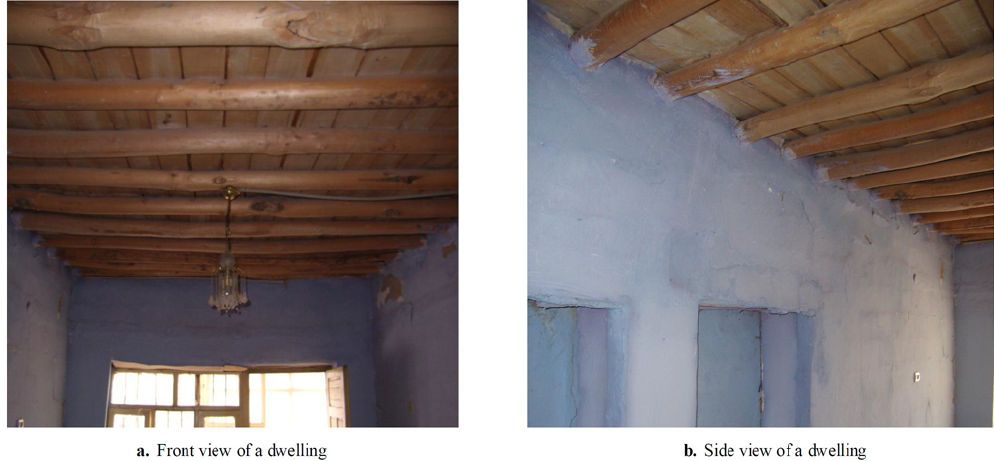
Fig. 11. Views from the interior of the traditional roof system with wooden sheathing.